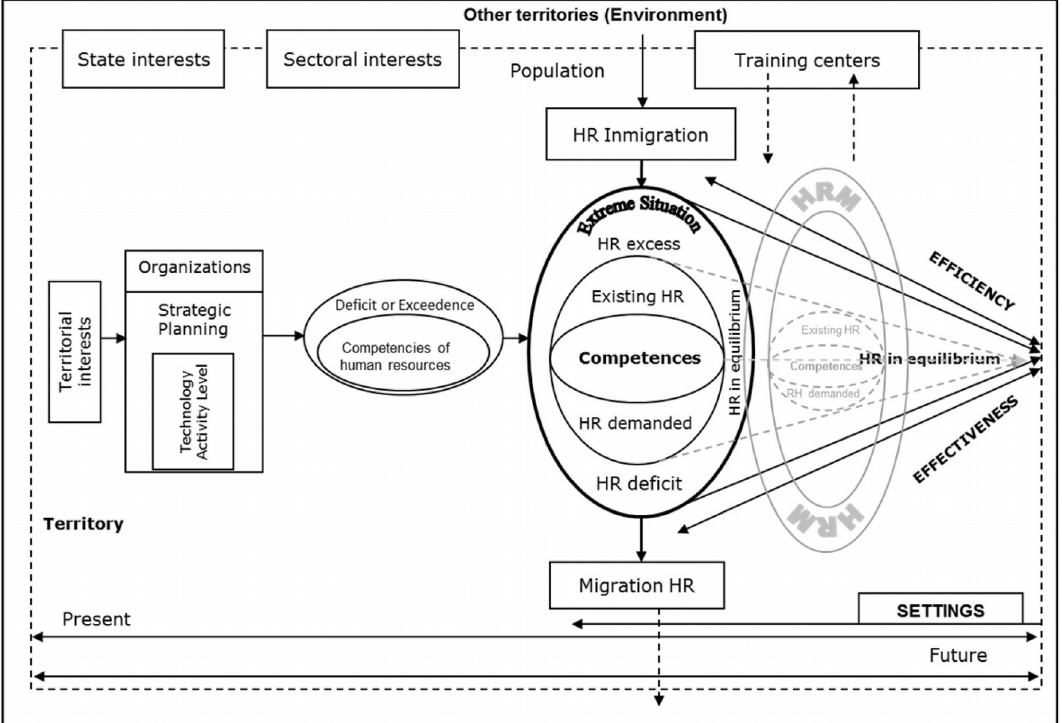
Figure 2. Conceptual model for the planning of human resources at territorial